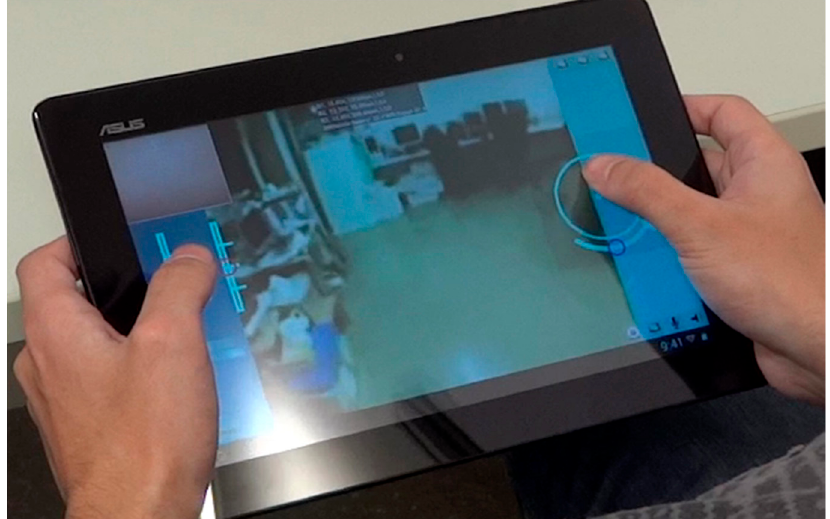
Figure 7. Android APP used for the remote control of the APR.